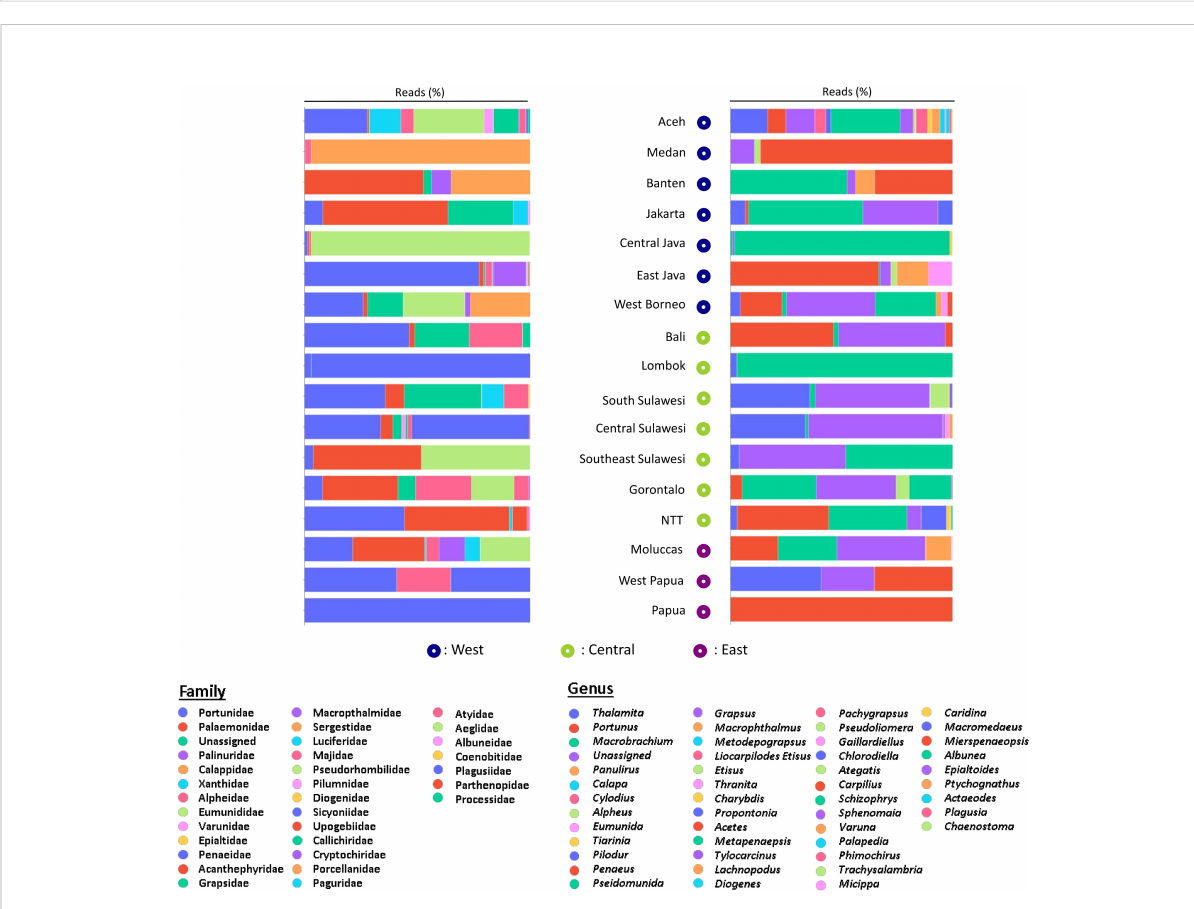
FIGURE 4 Relative abundance (based on percentage of reads) of decapod Families and Genera at sites in provinces in West, Central and East Indonesia (legends sorted from highest to lowest read